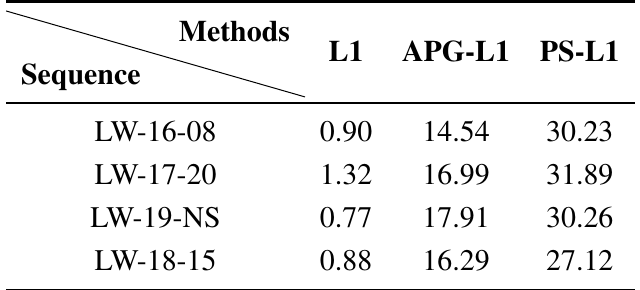
Table 3. Comparison of Computational Cost by